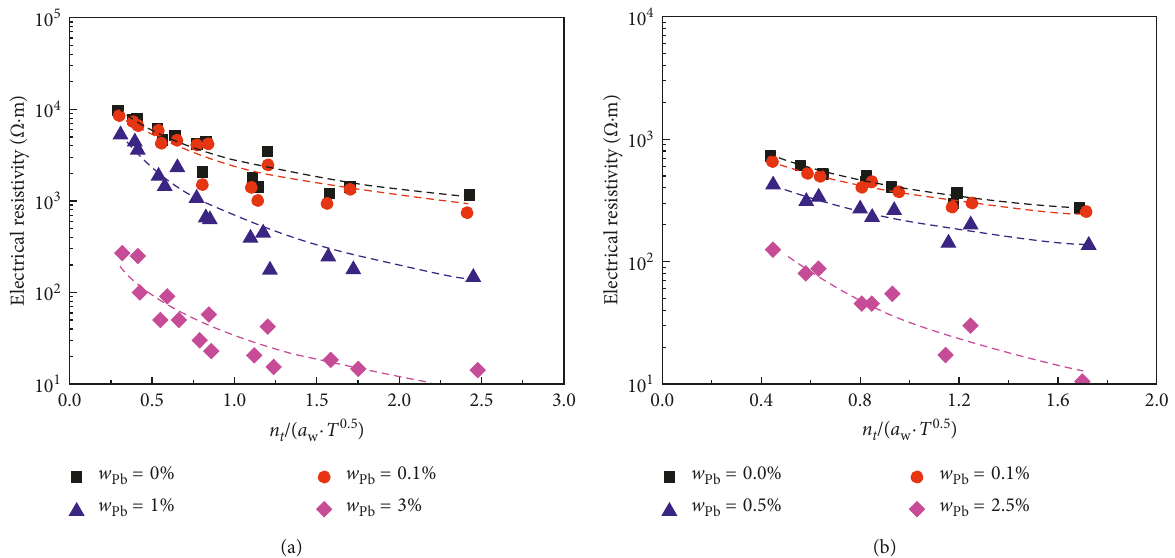
Figure 7: Relationship between electrical resistivity and n